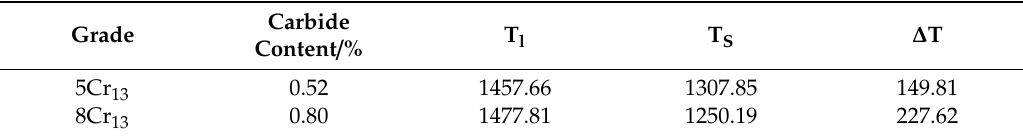
Table 6. Solid and liquid phase lines of di ff erent surfacing layers ( ◦